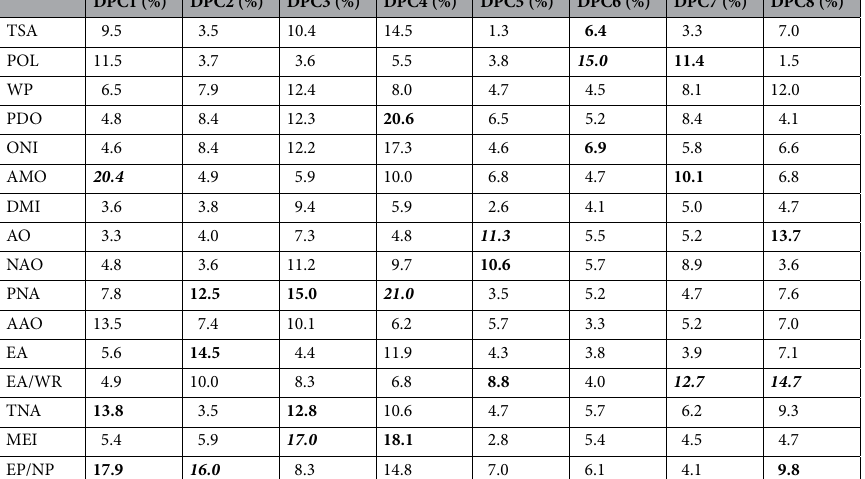
Table 1. PASC (%) for the wavelet transform coherence between DPCs and global climatic drivers. Italic indicates the most significant global climatic driver, and bold indicates the first three most significant global climatic